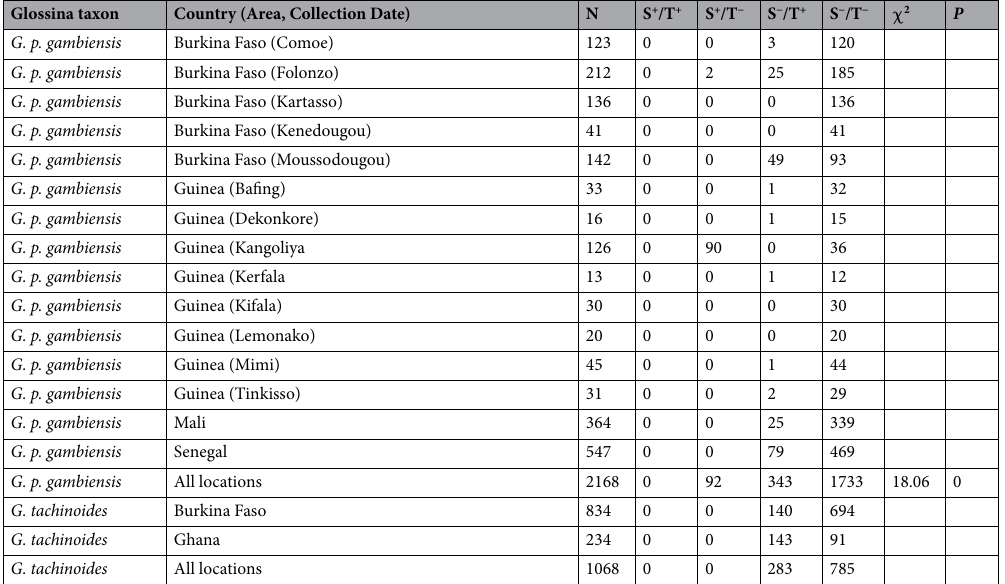
Table 5. Distribution of the association between the presence of Trypanosoma spp and the presence of Sodalis according to the tsetse species and the